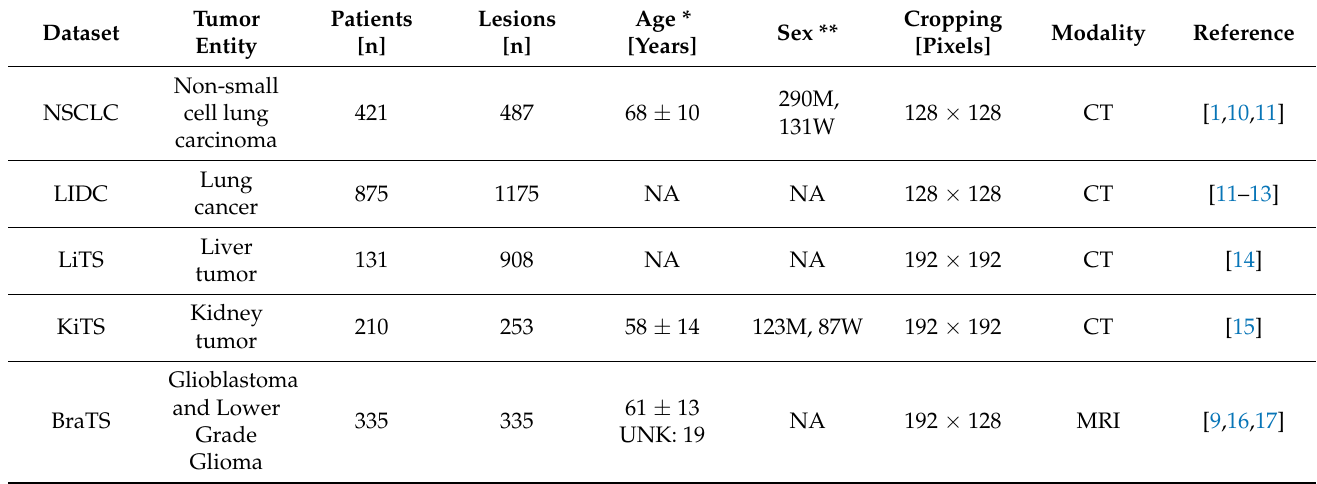
Table 1. Characteristics of image datasets used in this study. Data are given where available. NA—not